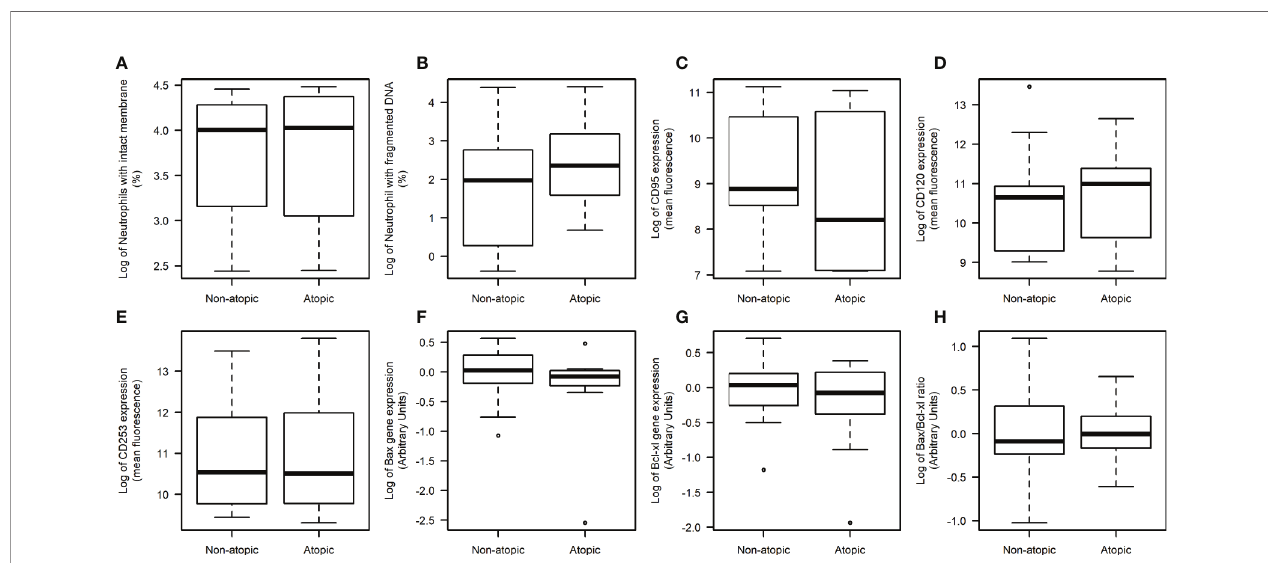
FIGURE 3 | Neutrophil death evaluation in non-atopic and atopic runners. Freshly obtained cells were isolated from the blood of non-atopic and atopic runners at rest. Percentage of neutrophils with an intact membrane (A) and DNA fragmentation (B) . The expression of Fas (CD95) (C) , TNFR2 (CD120b) (D) and TRAIL (CD253) (E) receptors on the neutrophil surface, as determined by fl ow cytometry. Ten thousand events were evaluated per experiment. The gene expression levels of Bax (F) , Bcl-xL (G) and the Bax/Bcl-xL ratio (H) as determined by qPCR. The expression levels were normalized using two housekeeping genes (YWHAZ and SDHA), as indicated by the geNorm program (Vandesompele et al., 2002). The data were analyzed by the 2 - DD CT method. The results are presented as medians (middle lines). The 25 – 75% con fi dence intervals (closed boxes) and the 5 – 95% con fi dence intervals (lower and upper lines, respectively) are